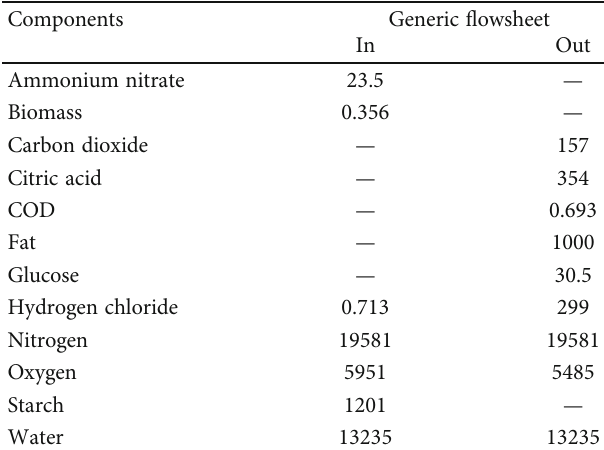
Table 3: Material Balance form